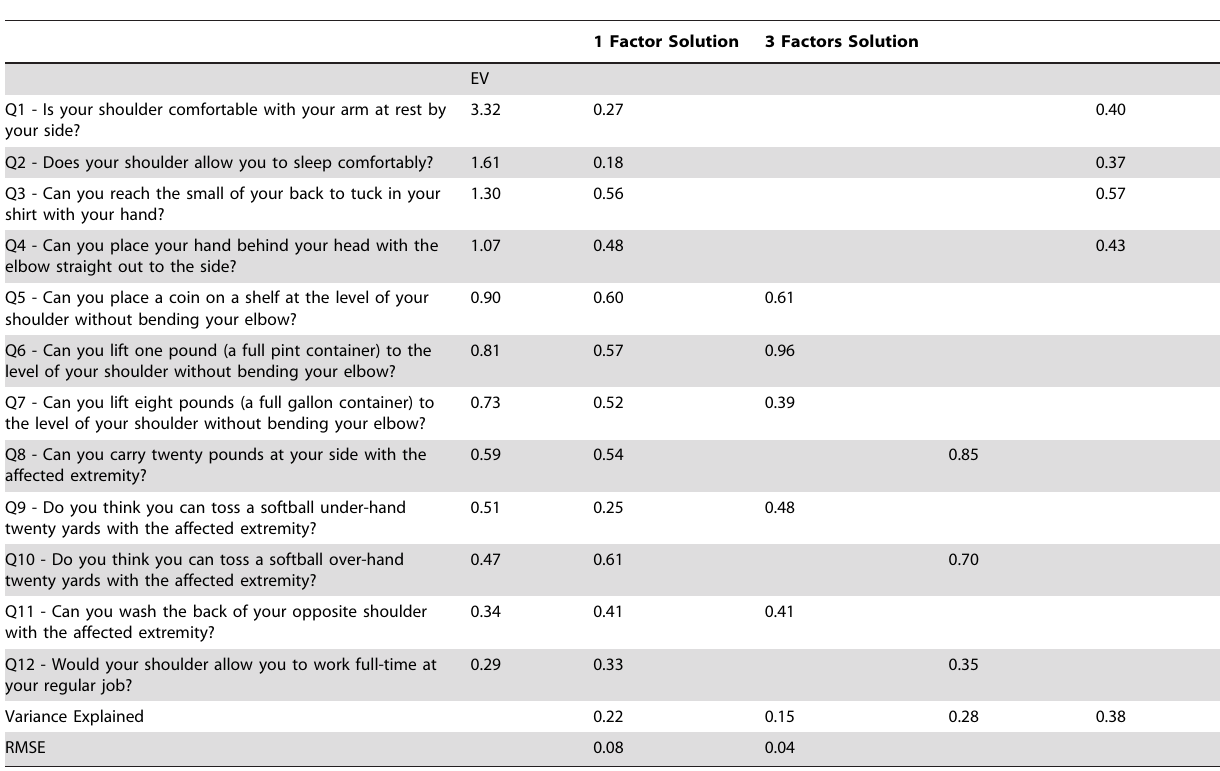
only 22%, while the 2 and 3-factors solution explained 32% and 38%, respectively. Nevertheless, a 2-factor solution was discarded during our interpretation since it indicated four observed variables (questions) with factor loadings lower than 0.35 (Table 3). The same problem was observed with the 1-factor solution. Since the Table 3. Exploratory factor analysis results for simple shoulder test’s validations to Brazilian-Portuguese.